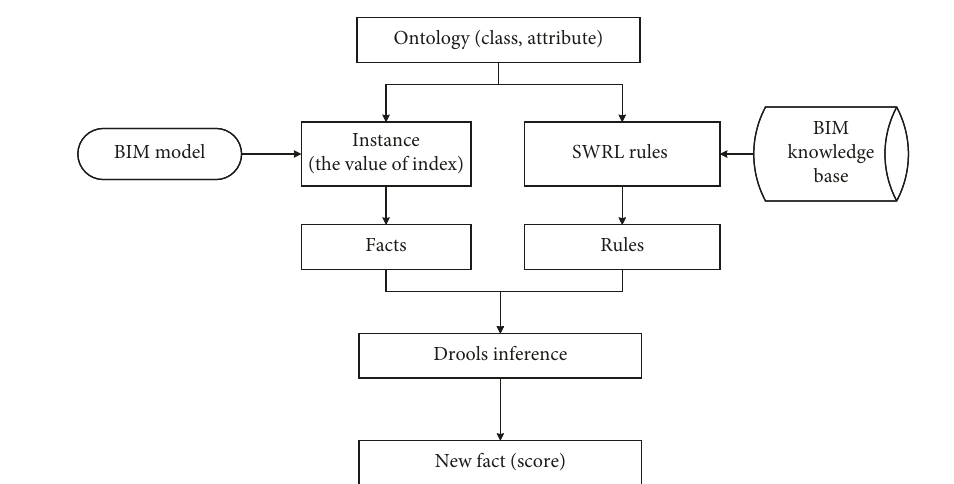
Figure 12: Flow chart of Drools